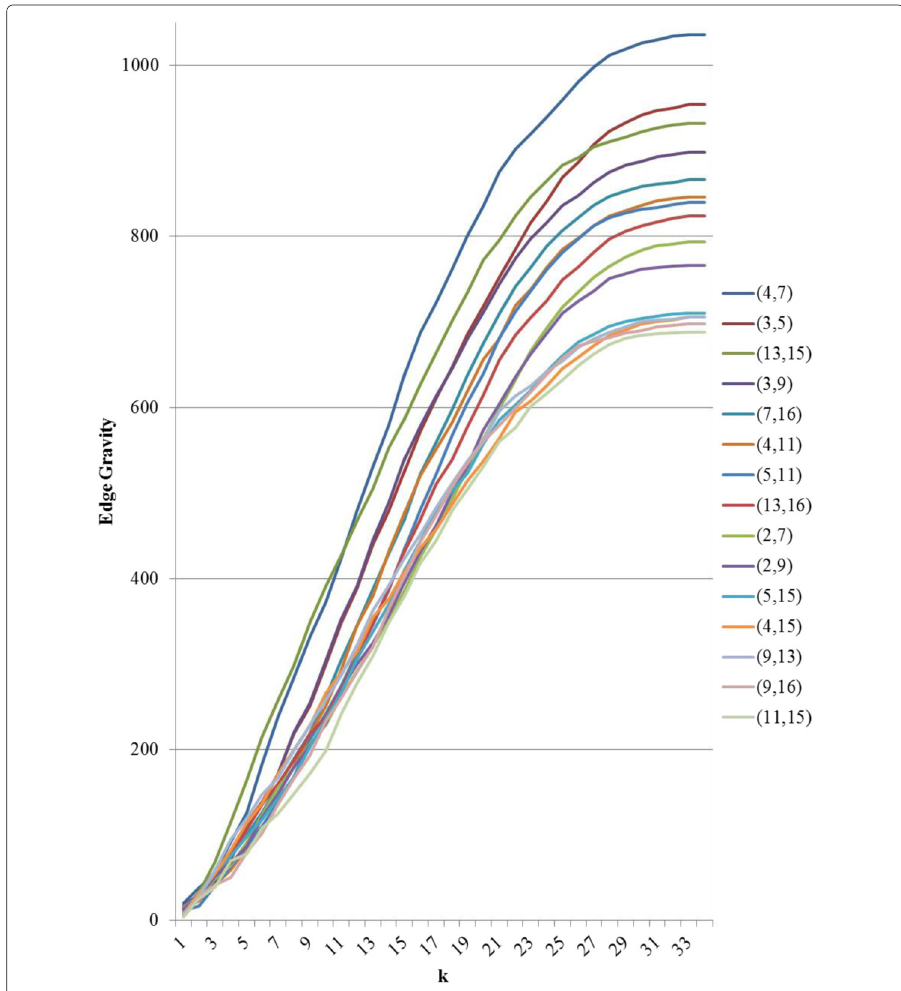
Fig. 17 Edge Gravity solutions for the Florentine families network, with bridges to nowhere removed, when solving the Edge Gravity Algorithm for k = 1,2,3, ... ,33 ( k ∗ = 33)